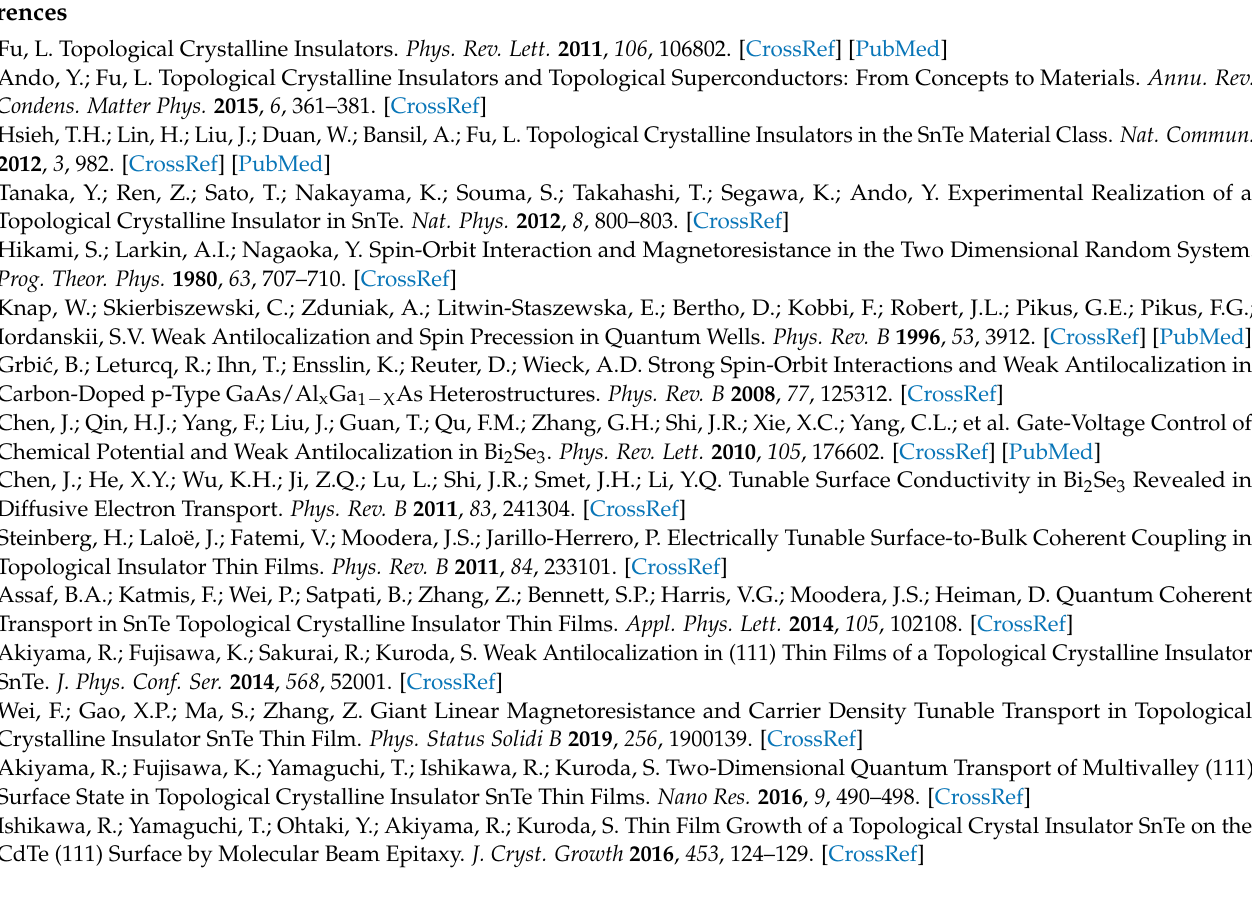
film, Figure S2: Additional R yx ( B ) data of devices A and B, Figure S3: Additional AFM images of SnTe